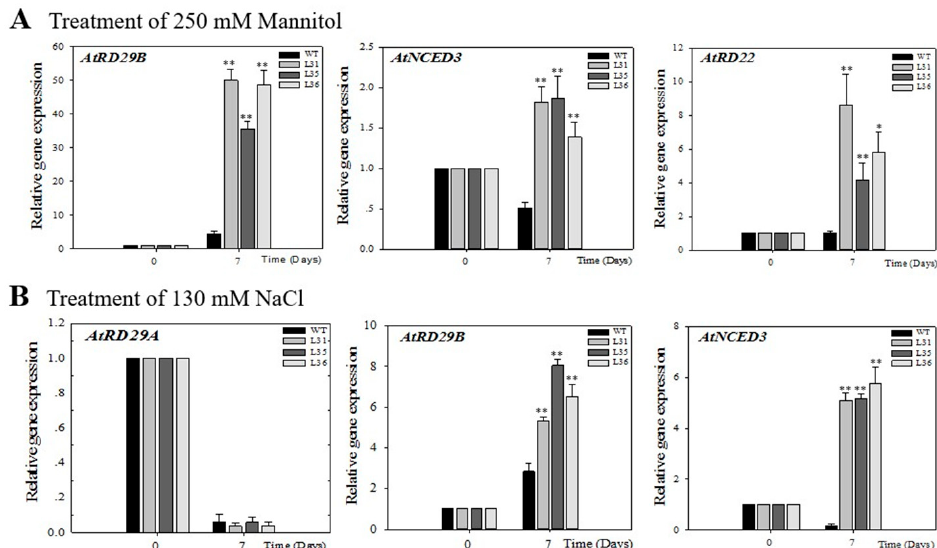
Figure 7. Assessment of the expression of stress-related genes in Arabidopsis seedlings after treatment with osmotic stress is shown in ( A ) and ( B ). The relative expression levels of osmotic stress-responsive genes were assayed in seedlings via qPCR 7 days following initiation of salt ( A ) and drought ( B ). Data represent mean values ± SD from three independent experiments. Asterisks indicate significant differences between WT and transgenic lines as determined by Student’s t -test (* 0.01 < p < 0.05, ** p < 0.01).